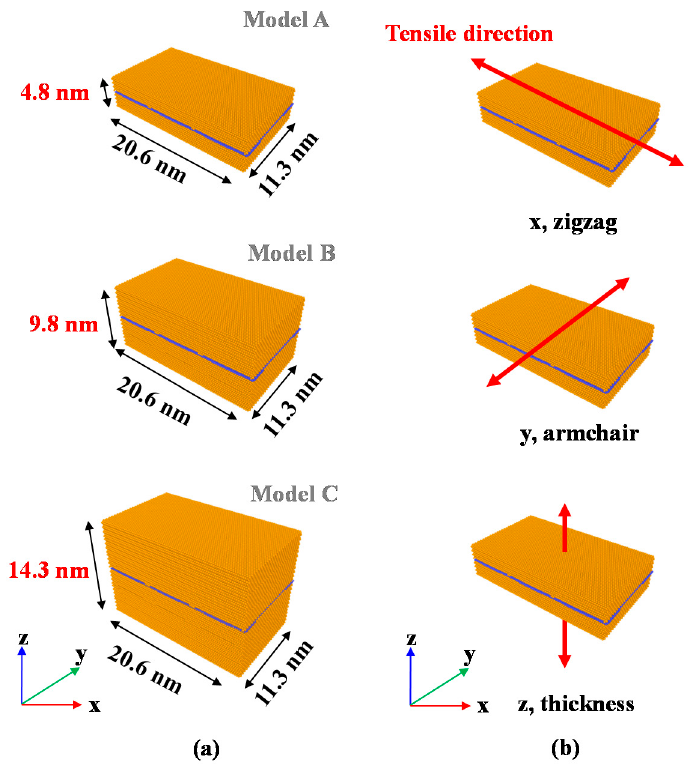
Figure 1. MD model for graphene/Cu composite modeling conditions: ( a ) produced model sizes; ( b ) formed tensile directions of zigzag-, armchair-, and z (thickness)-directions.